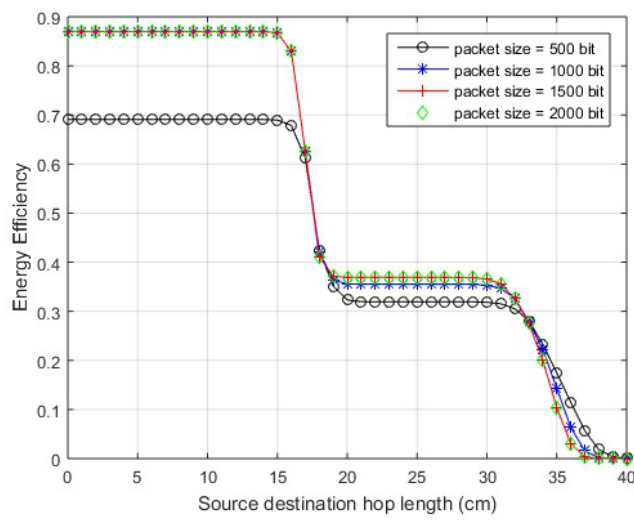
Figure 8. Energy efficiency over distance for proposed scheme (in-body communication).